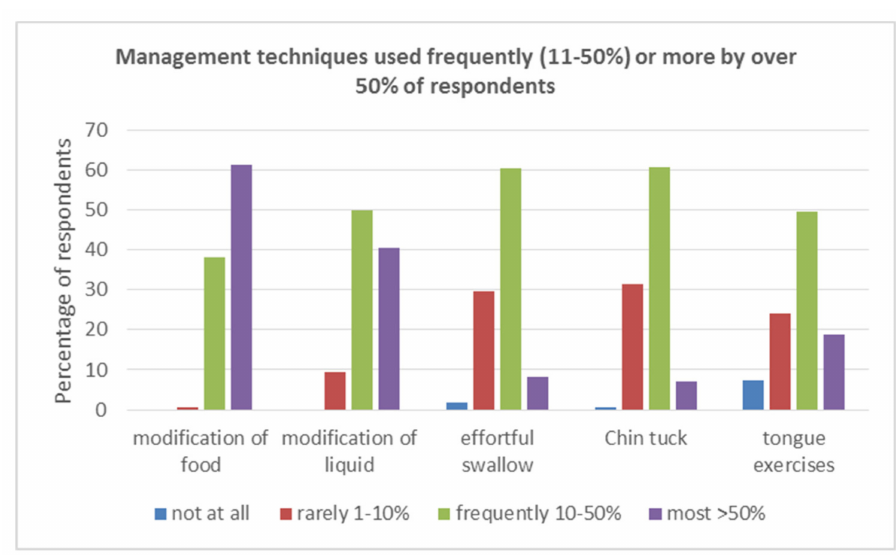
Figure 2. Management techniques used Frequently (11–50%) or More ( > 50%) by over 50% of respondents.